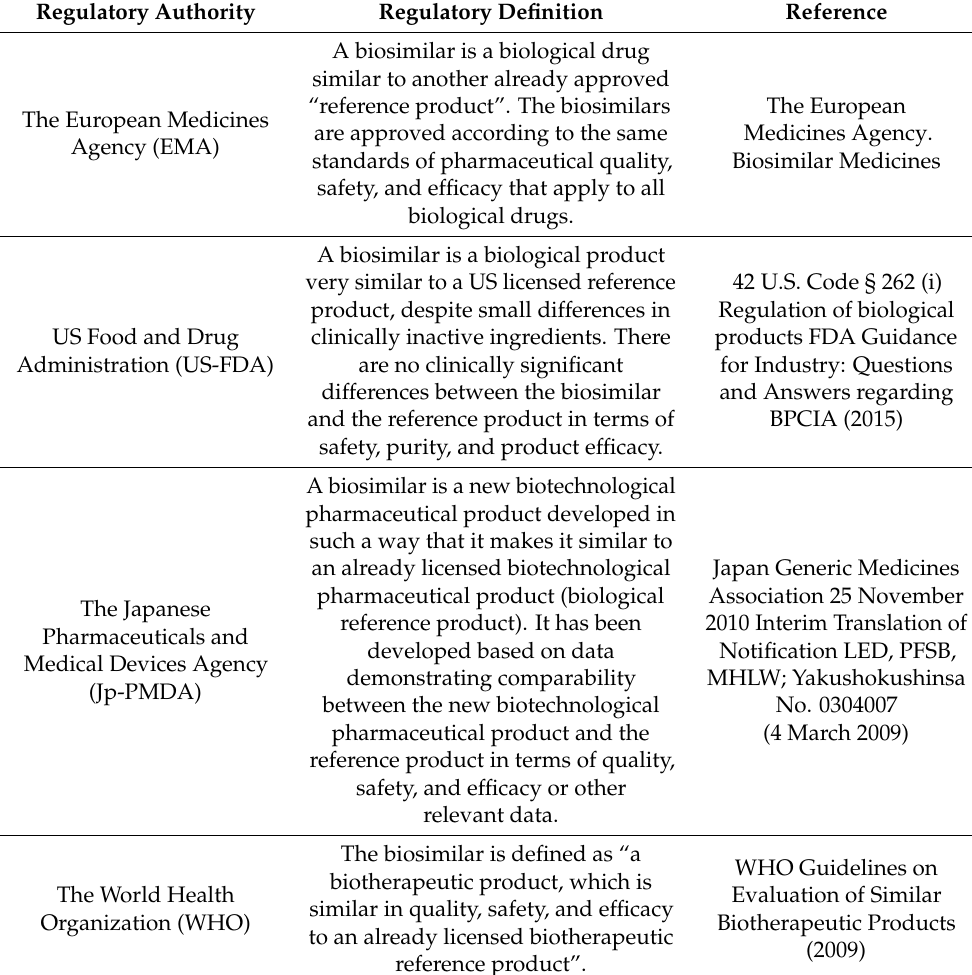
Table 2. Definition of biosimilars according to international regulatory organizations